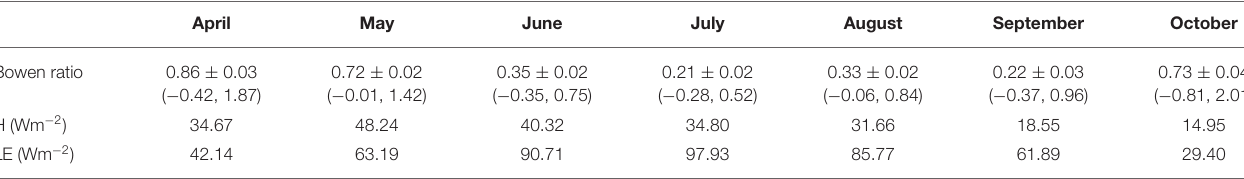
TABLE 1 | Energy balance at the sheltered fen.